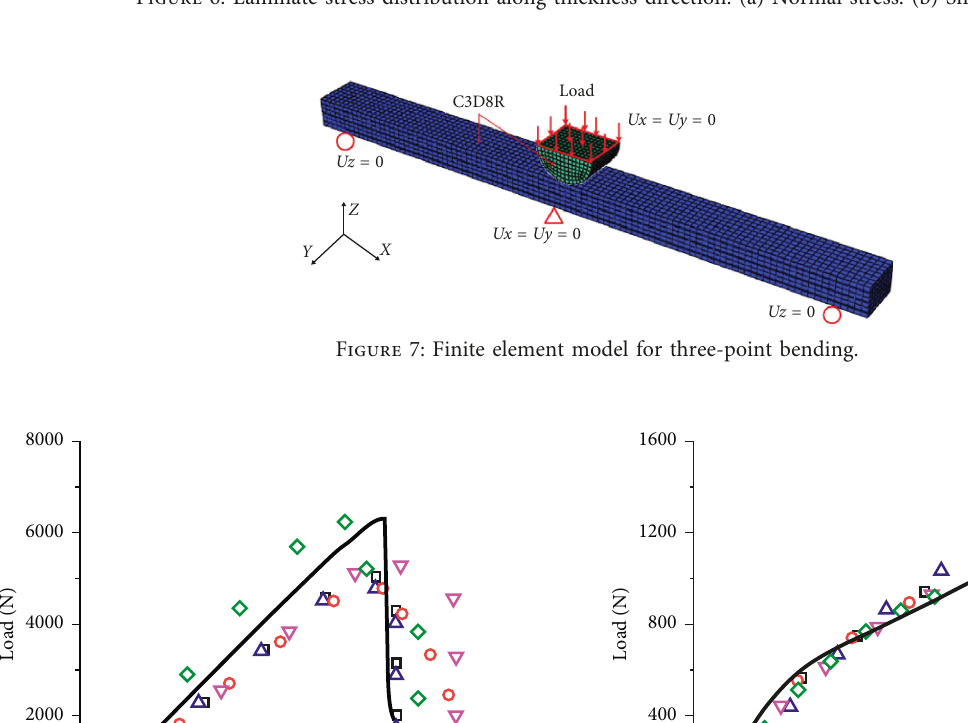
Figure 6: Laminate stress distribution along thickness direction. (a) Normal stress. (b) Shear stress.